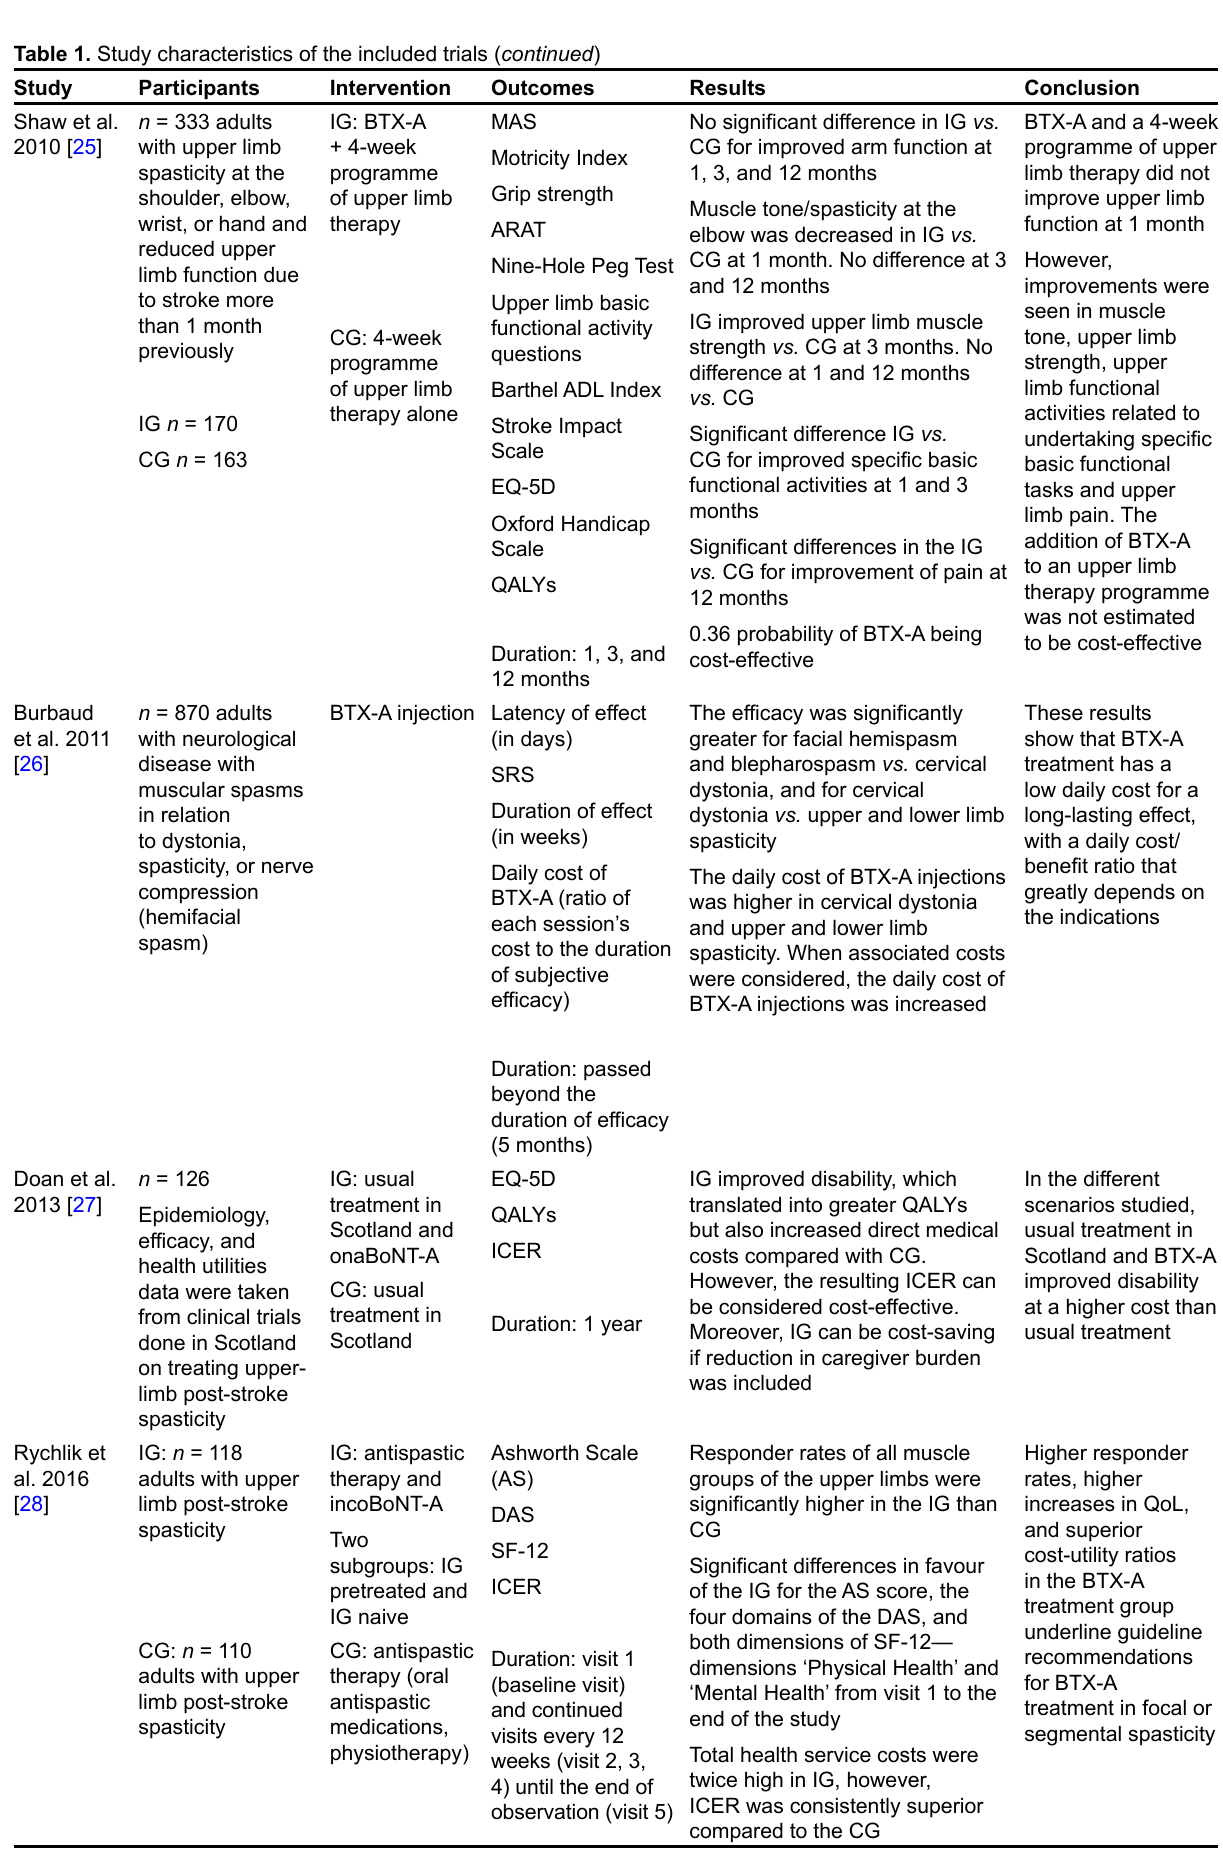
Table 1. Study characteristics of the included trials ( continued )